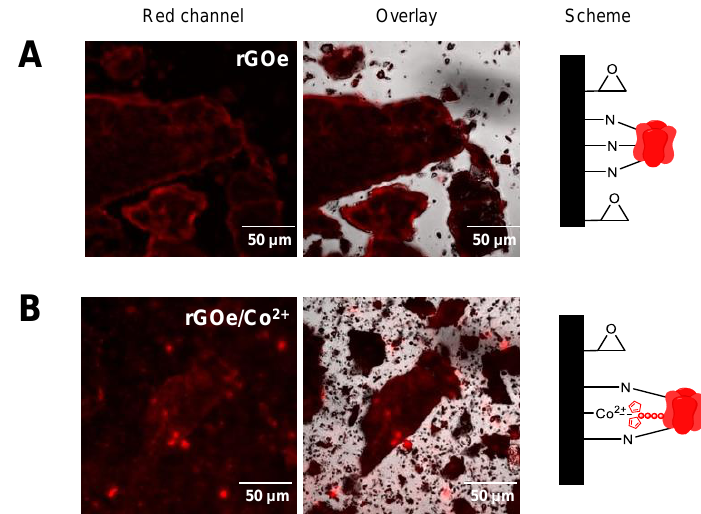
Figure 1. CLSM images of His-RFP immobilized on graphene-based carriers: ( A ) rGOe; ( B ) rGOe-Co 2 + . Both carriers were loaded with 1mg protein × g −1 carrier. From left to right: red channel (λ ex : 561 nm , λ em : LP565 nm ) , overlay of fluorescence and brightfield signals, and the scheme of the protein immobilization.